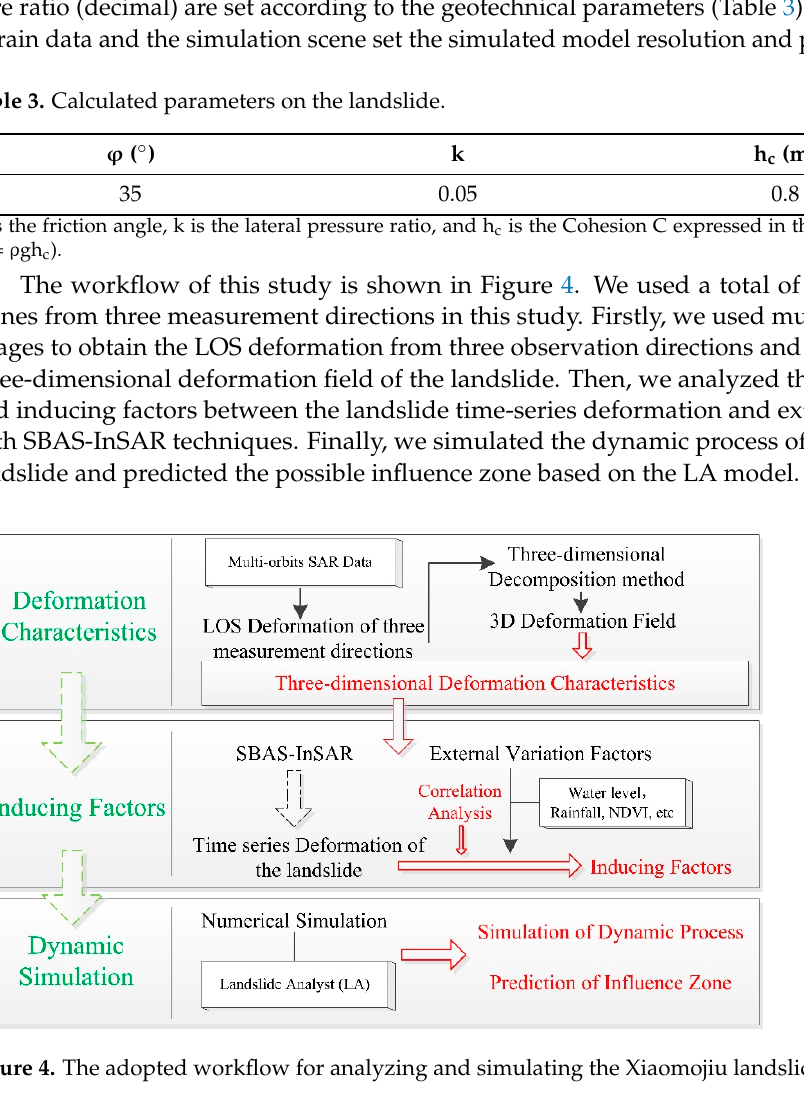
Figure 4. The adopted workflow for analyzing and simulating the Xiaomojiu